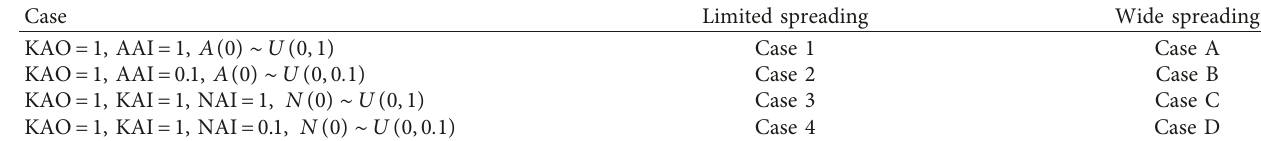
Table 3: The set of cases to simulate.